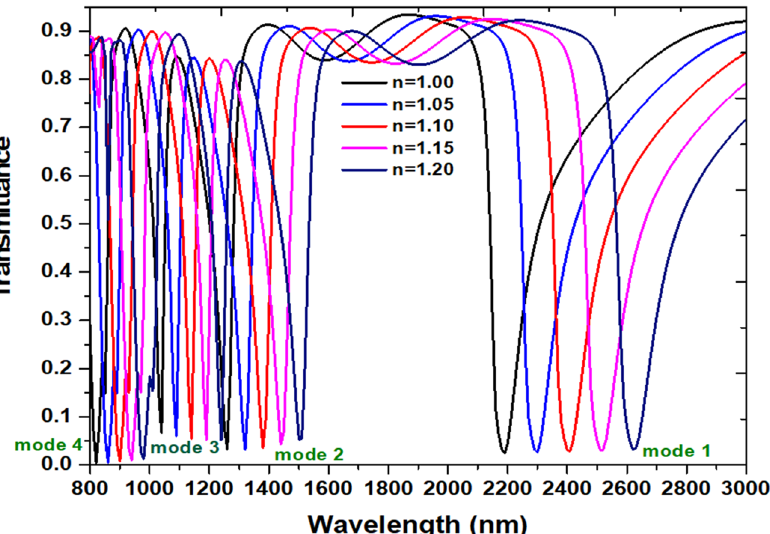
Figure 4. Transmittance spectra of the case 2 structure with the filling media ( n ) of 1.00, 1.05, 1.10, 1.15, and 1.20, respectively. The other parameters keep the same as used in Fig. 2.